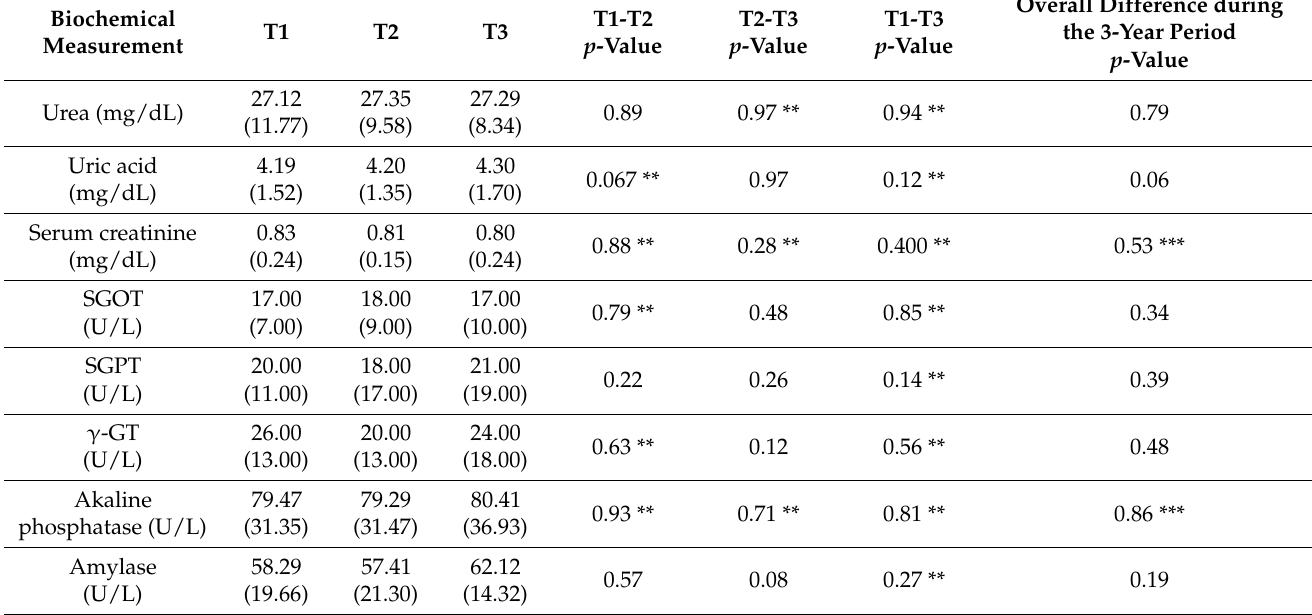
Table 2. Changes (difference tests) in the biochemical measurements of forensic psychiatric patients taking second-generation antipsychotics with a low risk of weight gain (AP1) over the three-year study period (time points T1, T2, T3) (N = 17).